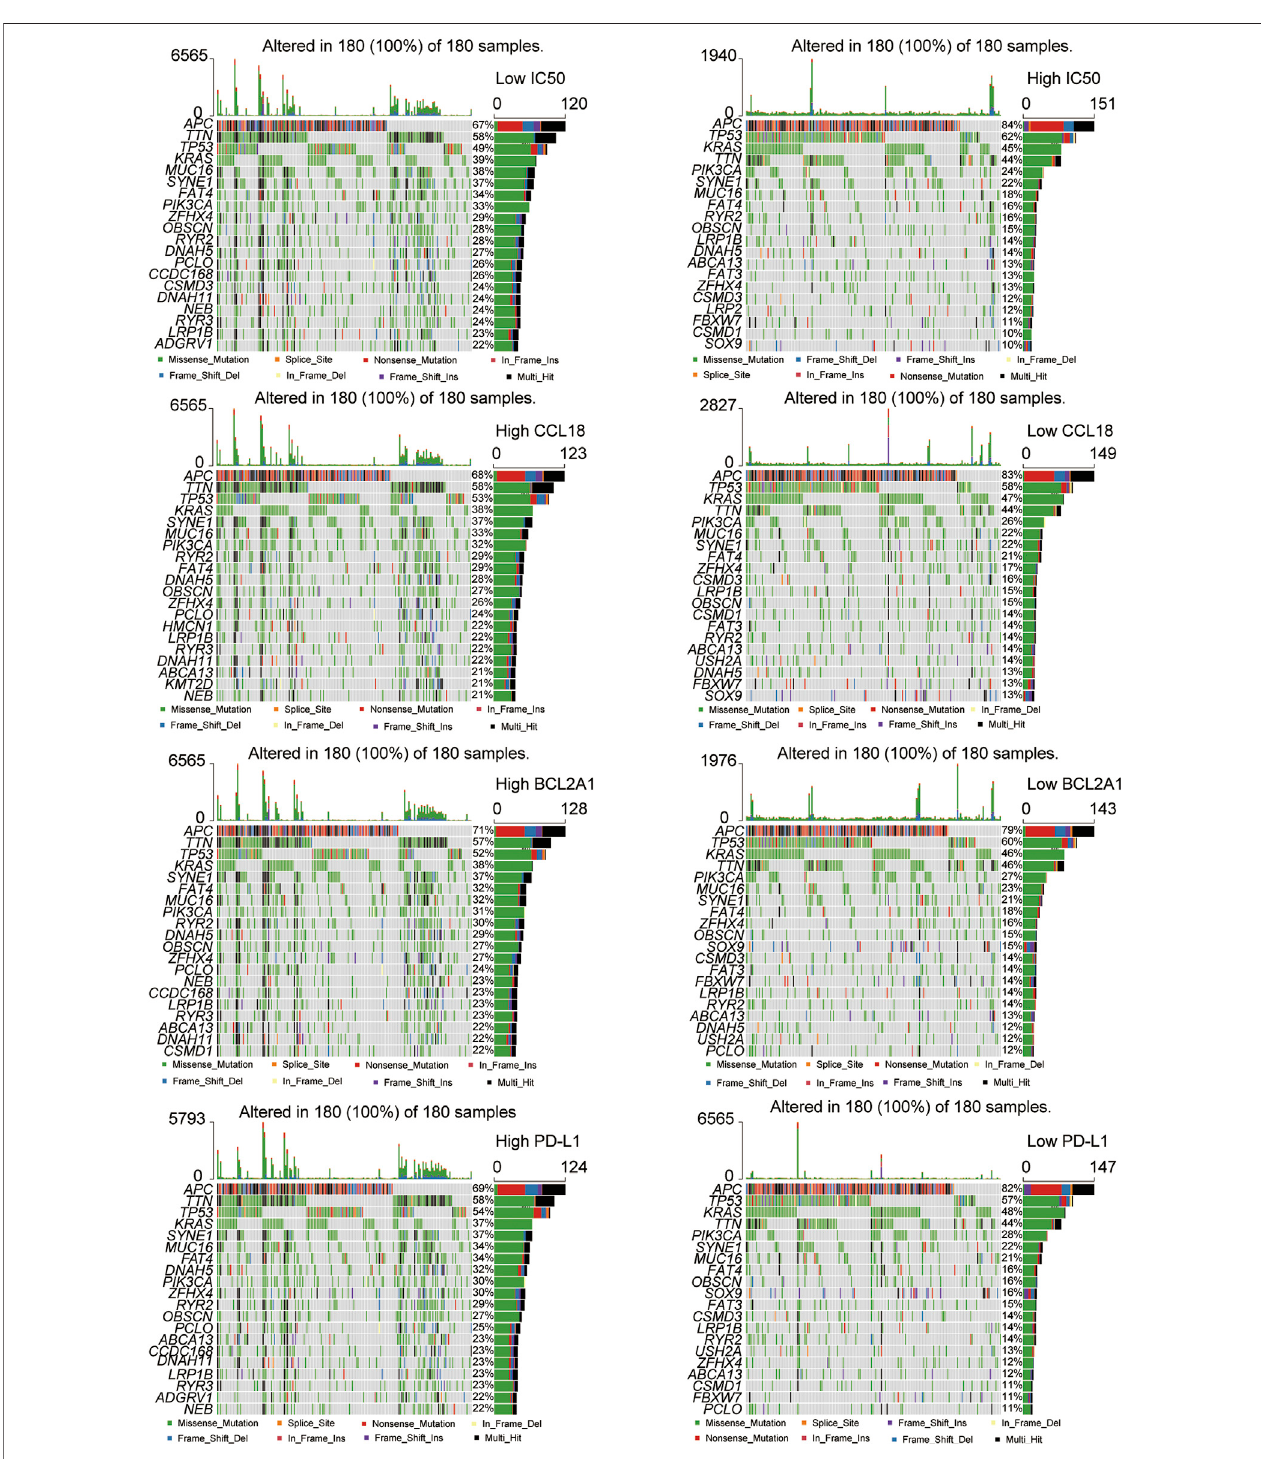
FIGURE10| Thelandscapesofsomaticmutations.Thelow-IC50groupandthehighCCL18orBCL2A1orPD-L1grouphad moresomaticmutationfrequencies.